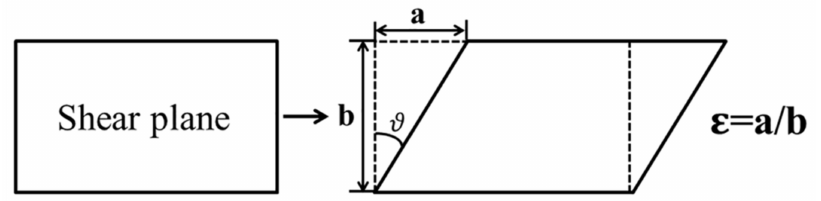
Figure 3. Schematic presentation of the relationship between shear deformation ε and shear angle θ